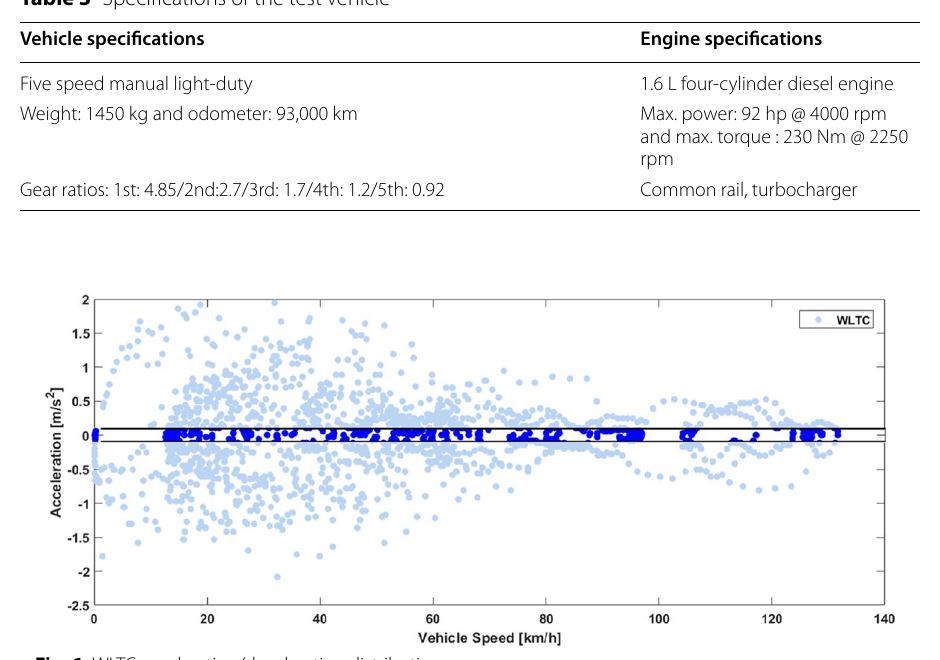
Fig. 6 WLTC acceleration/deceleration distribution